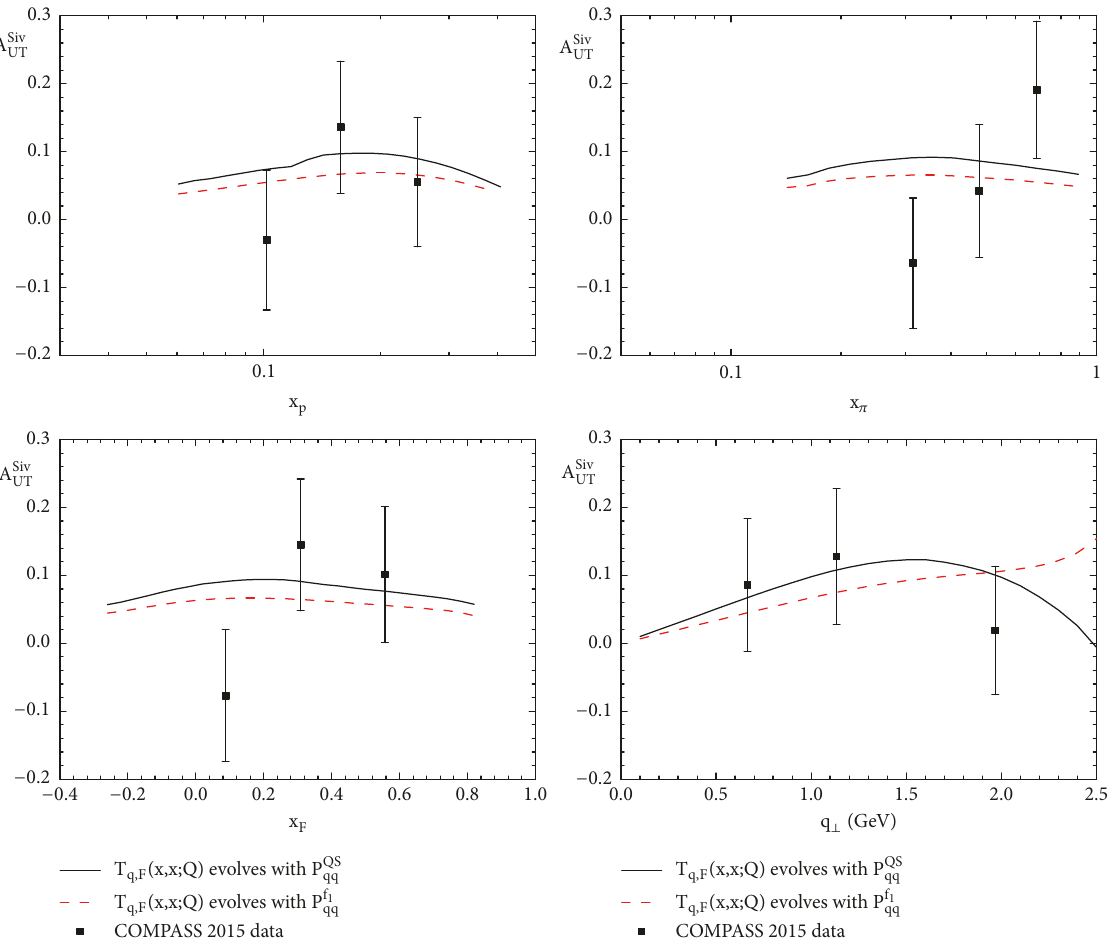
Figure 6: The Sivers asymmetry within TMD factorizationfor a 𝜋 − scatteringoff transversely polarized proton Drell-Yanprocess as functions of 𝑥 𝑝 (upper left), 𝑥 𝜋 (upper right), 𝑥 𝐹 (lower left), and 𝑞 ⊥ (lower right), compared with the COMPASS data [11]. Figure from